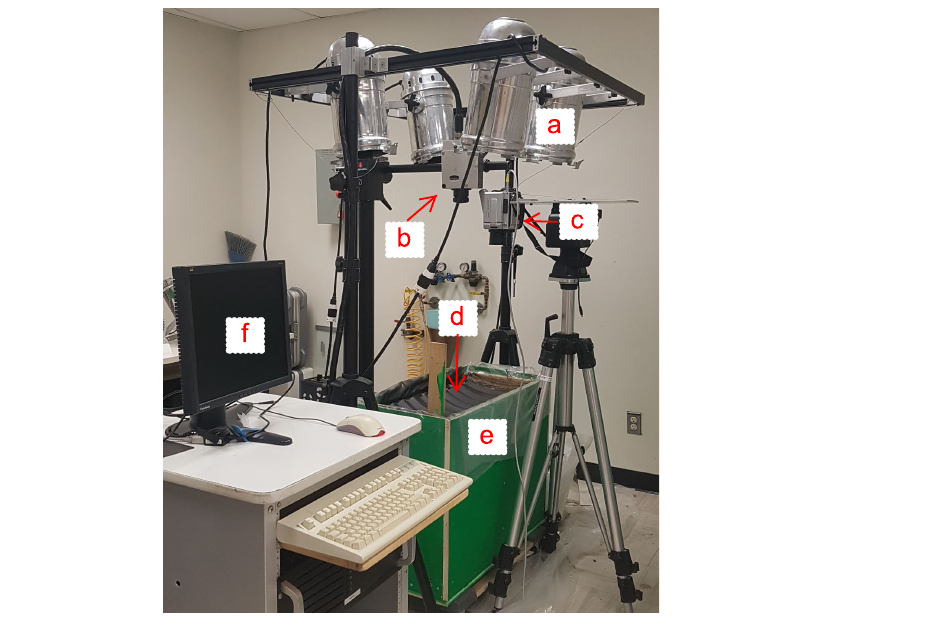
Figure 2. The real experiment setup. ( a ) Halogen Lamp, ( b ) IR Camera 1 (FLIR Phoenix), ( c ) IR Camera 2 (Jenoptik VarioCAM), ( d ) Specimen, ( e ) Box (filled with sand and gravel), ( f ) PC.